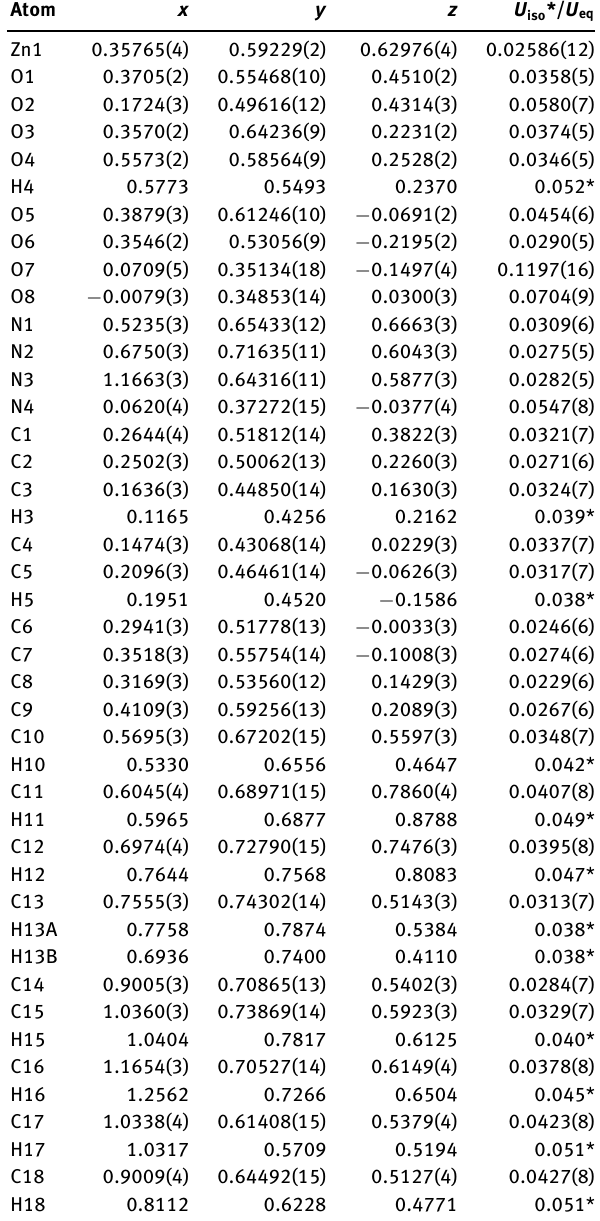
Table 2: Fractional atomic coordinates and isotropic or equivalent isotropic displacement parameters (Å 2